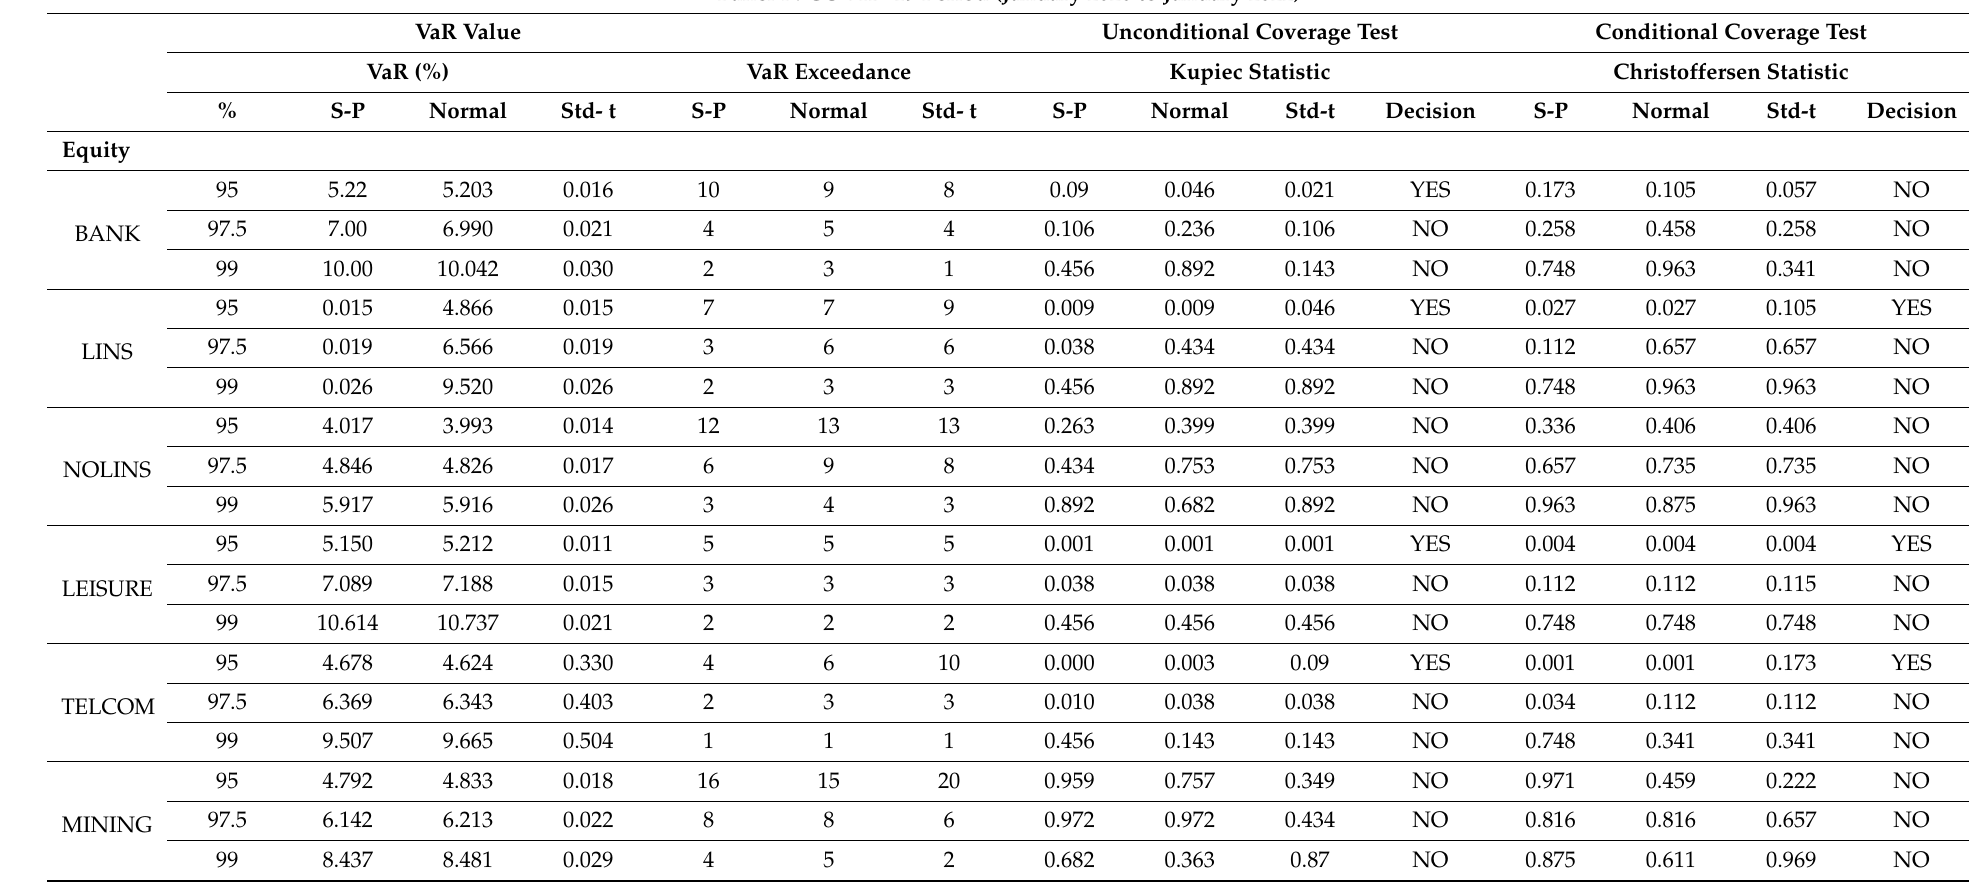
Panel B: COVID-19 Period (January 2020 to January